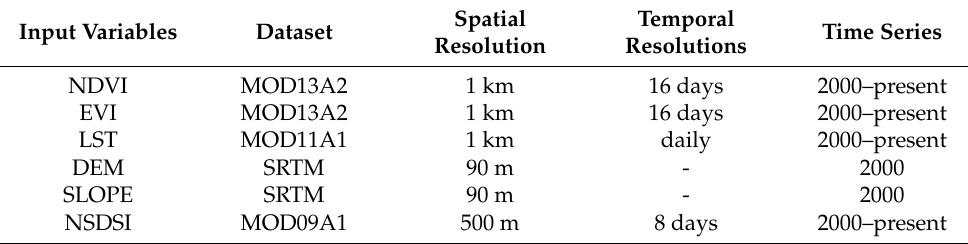
Figure 2. Map of vegetation cover (MCD12Q1). Table 2. Summary of auxiliary input